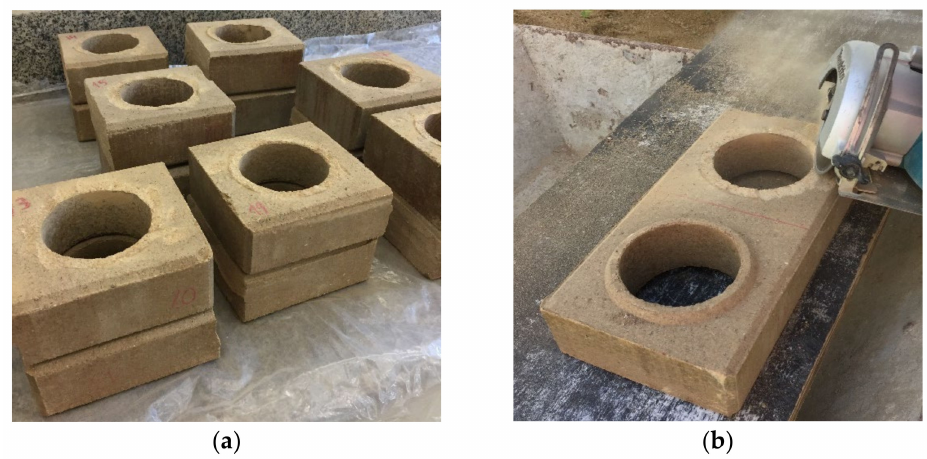
Figure 2. Brick capping step: ( a ) Bricks cut in half; ( b ) upper part of socket